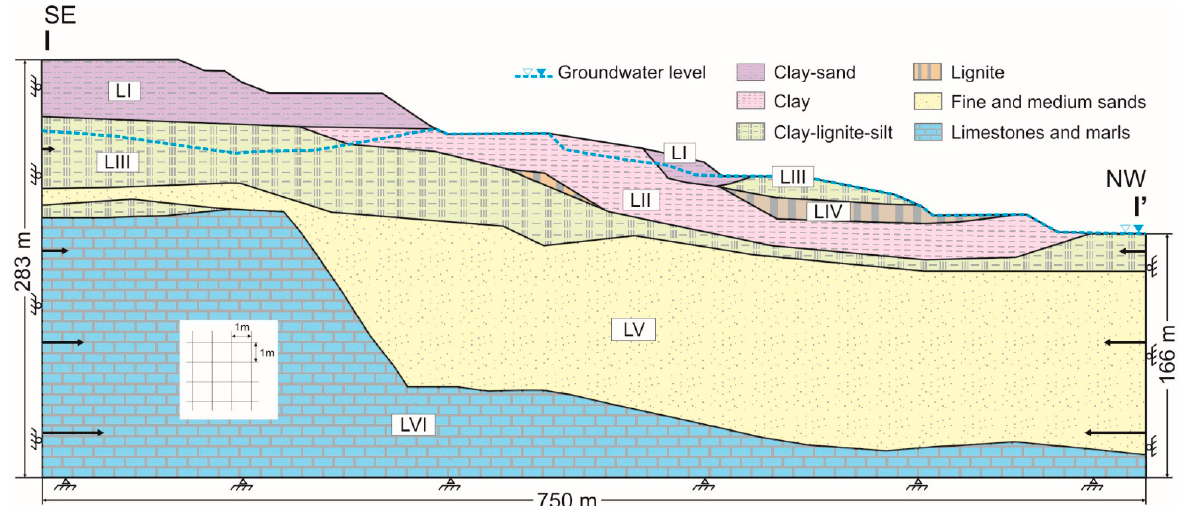
Figure 11. Calculation model of the 18S landslide in the Be ł chatów open-pit mine.